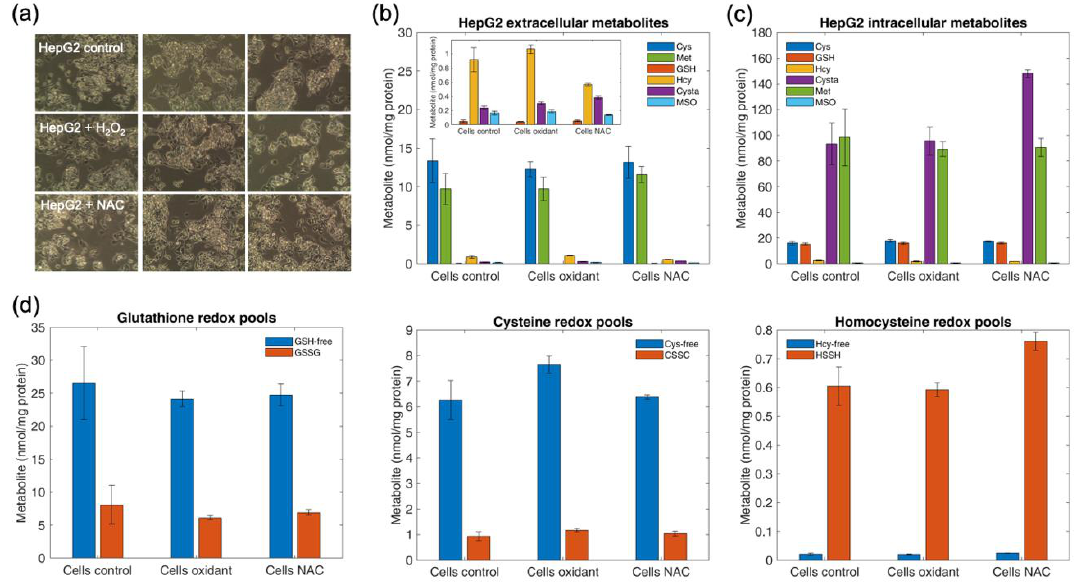
Figure 8. Thiol and thioether profiles in HepG2 cells treated with hydrogen peroxide or N -acetylcysteine. HepG cells were grown in normal culture medium (control) or in normal culture medium supplemented with 100 µ M hydrogen peroxide (H 2 O 2 , oxidant) or 1 mM N -acetylcysteine (NAC) for 24 h. An aliquot of conditioned culture medium was taken to profile extracellular thiol and thioether metabolites. Cells were harvested and processed with APS to quantitate intracellular thiol and thioether metabolites in their oxidized and redox forms. Panel ( a ). HepG2 cells, triplicates in rows, under the di ff erent experimental conditions. Panel ( b ). Extracellular metabolites. Each bar represents the sum of oxidized and protein-bound disulfide metabolites, obtained upon treatment of the sample with DTT. Panel ( c ). Intracellular metabolites. Each bar represents the sum of oxidized and protein-bound disulfide metabolites, obtained upon treatment of the sample with DTT. Panel ( d ). Intracellular pools of free reduced and oxidized cysteine, glutathione and homocysteine. Values are expressed as the mean ± standard deviation.